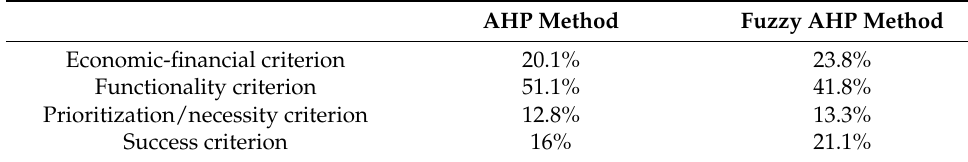
Table 5. Comparison of the evaluated criteria.